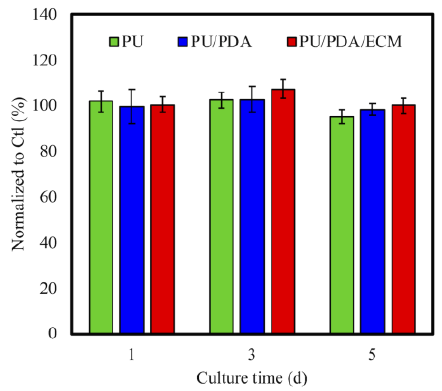
Figure 6. Quantification of a cytotoxic test of extract solutions of PU, PU/PDA, and PU/PDA/ECM conduits relative to controls on L929 cells for different time-points.